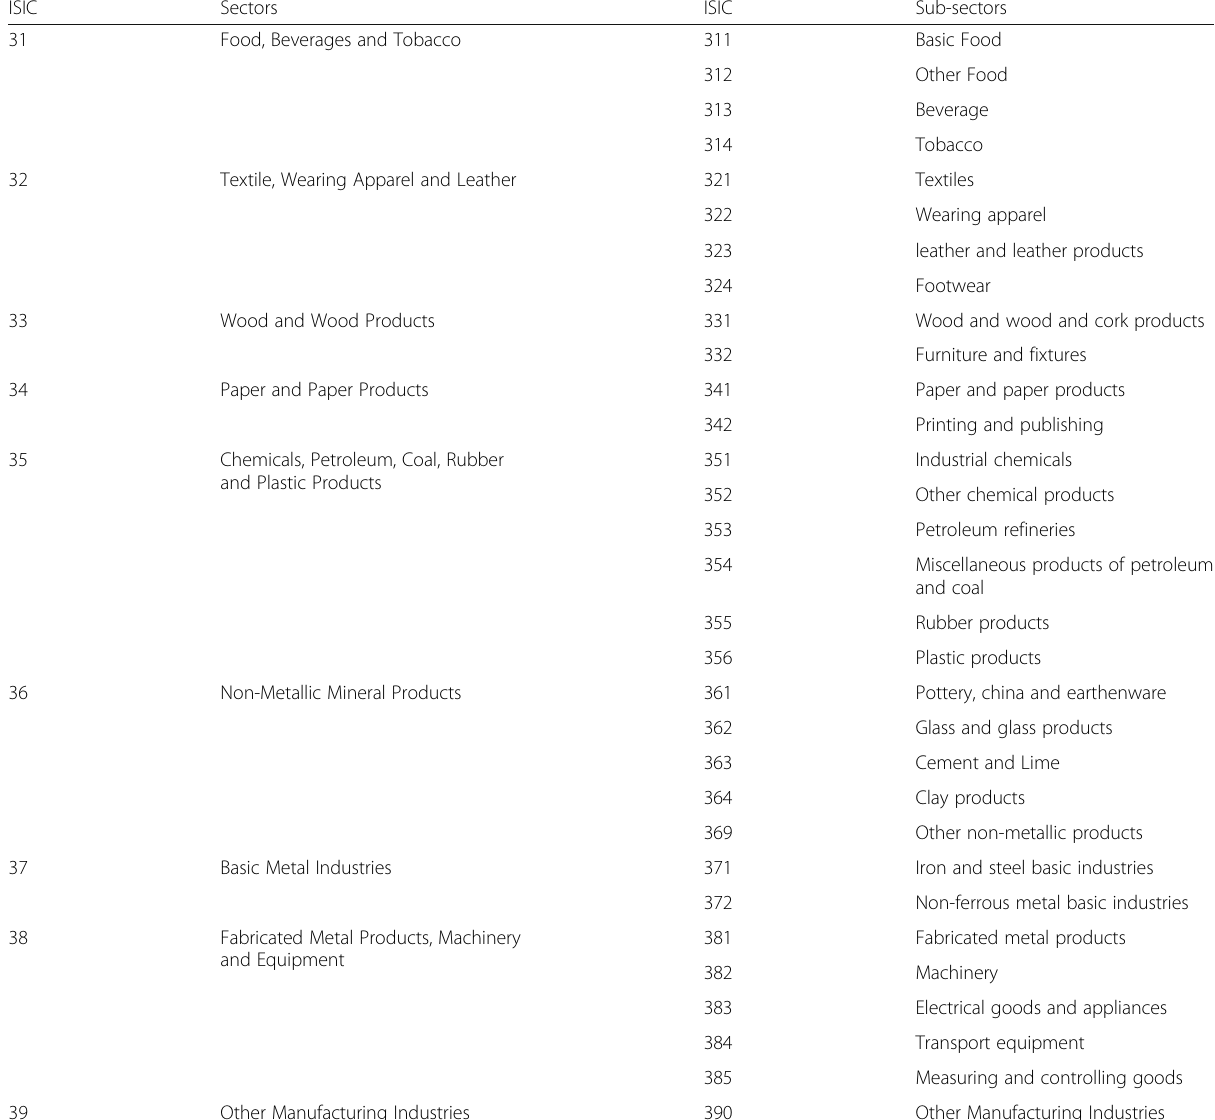
Table 1 ISIC-2 Indonesia ’ s economic activities classification